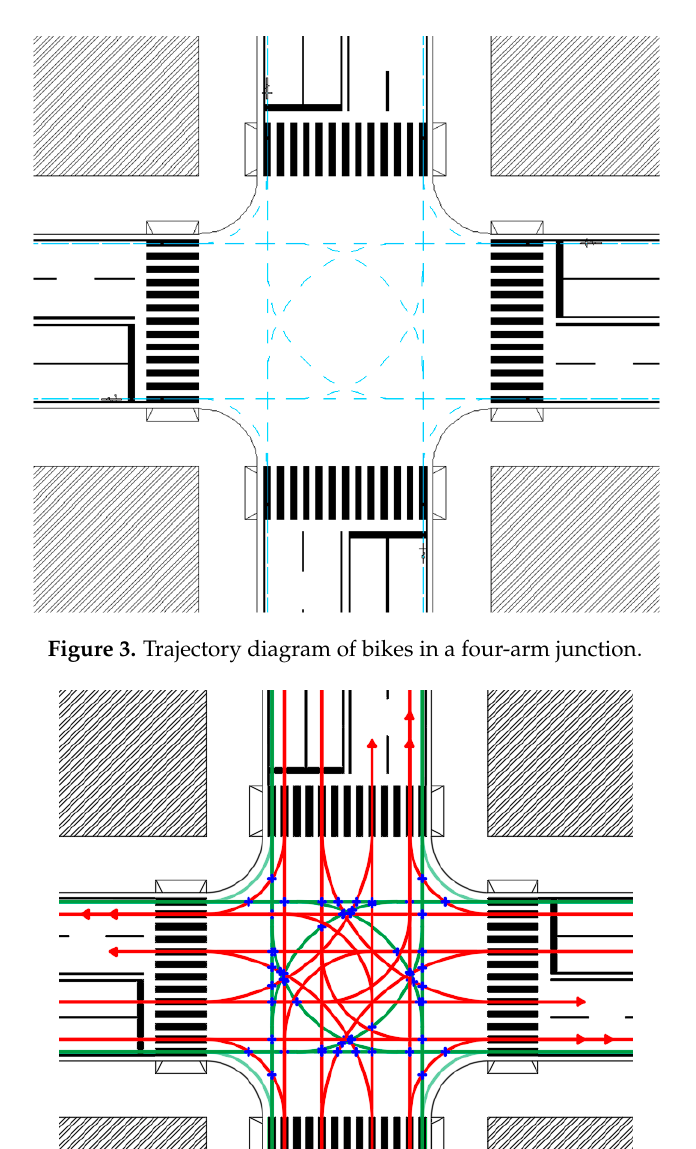
Figure 4. Example of conflict point detection at a four-arm junction.